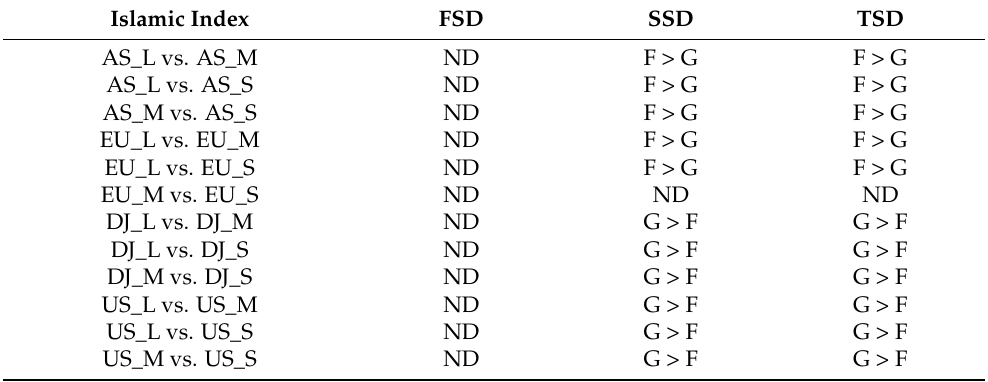
Table 5. Descending Stochastic dominance results (DSD) of Davidson and Duclos test (1996–2019).